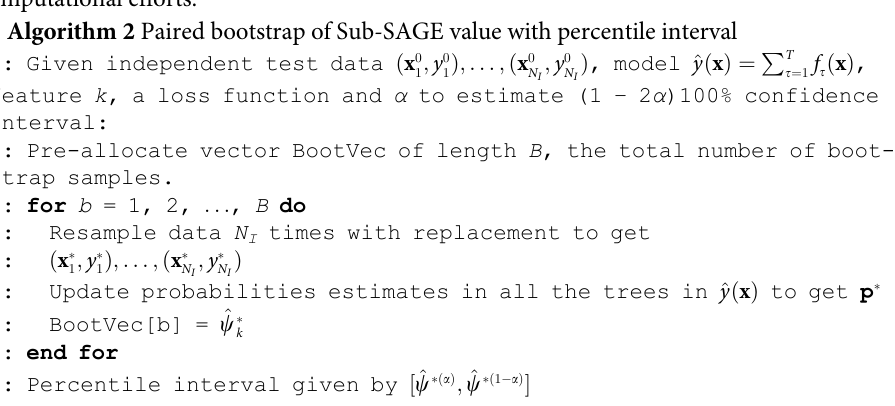
Algorithm 2 Paired bootstrap of Sub-SAGE value with percentile